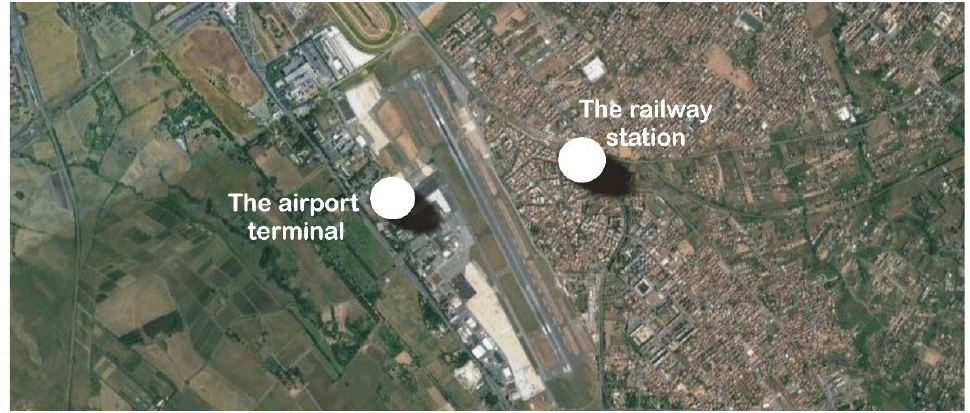
Figure 1. Aerial view of Ciampino airport and surrounding area.